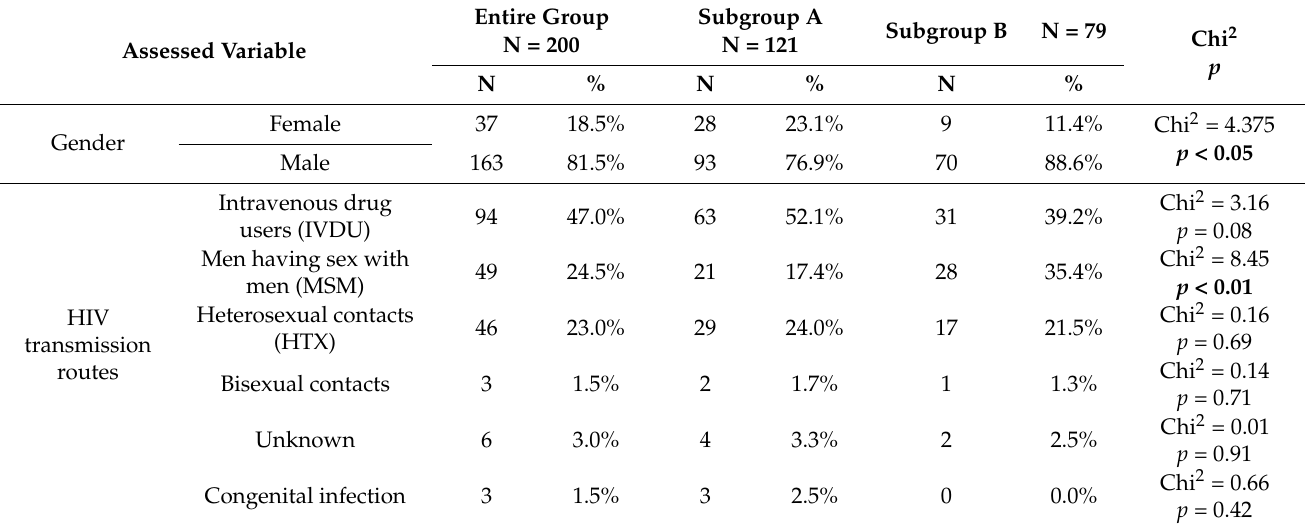
Table 3. Sex distribution and the route of HIV infection in particular patient